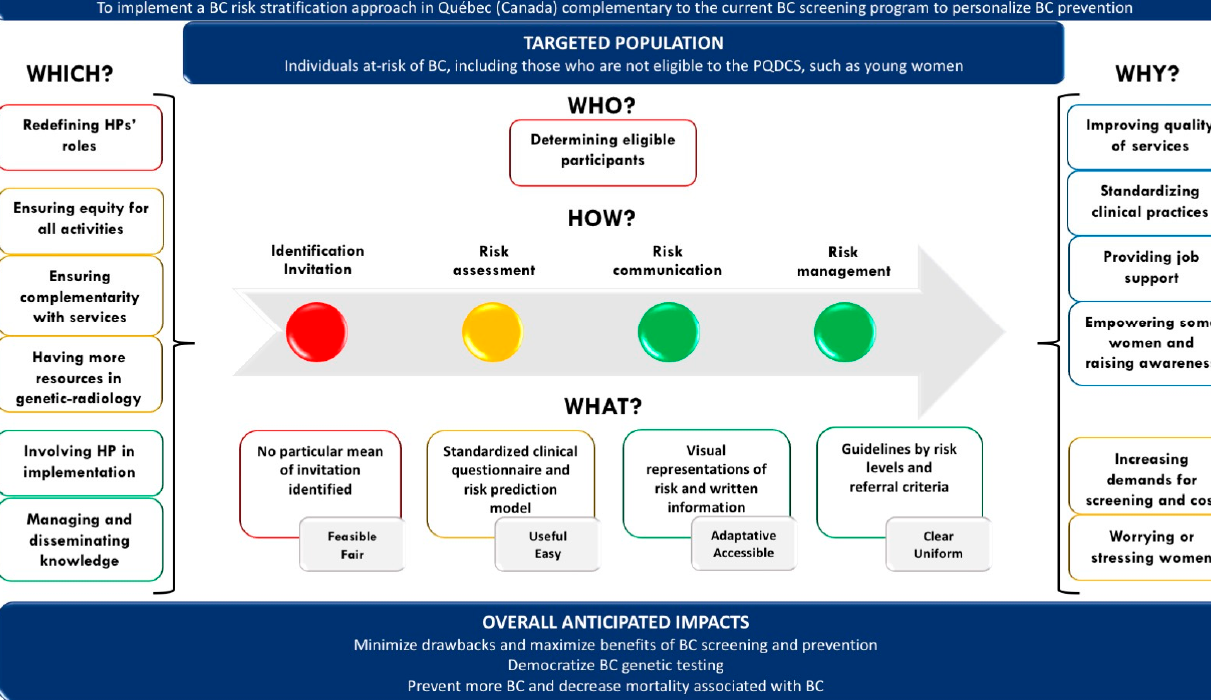
Figure 1. Results embedded in a logical model *. * Only information in white figures represents respondents’ answers. The contextualization elements of the study are in shown in dark blue. PQDCS: Programme québécois de dépistage du cancer du